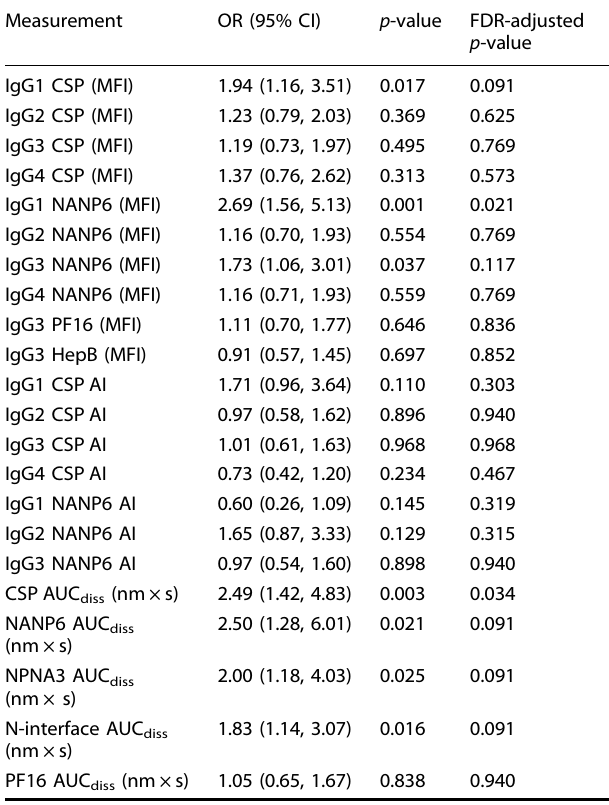
Table 4. Univariate Logistic Regression